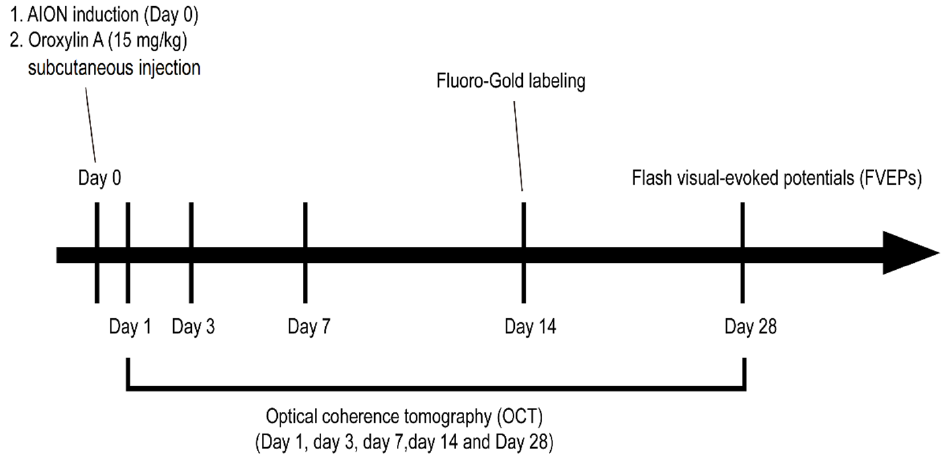
Figure 1. Schematic of the experimental design and procedures for Oroxylin A (OA) treatment in the rat anterior ischemic optic neuropathy (rAION) model.